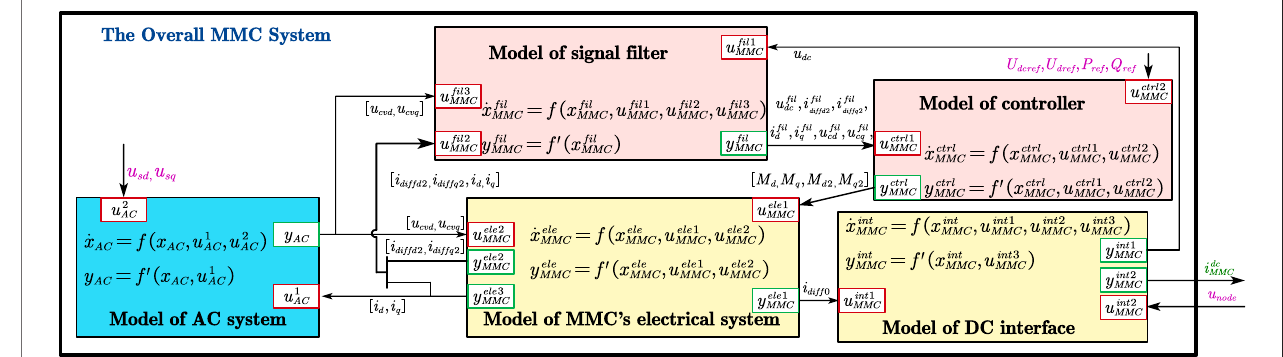
FIGURE 6 | Model of the overall MMC system with the